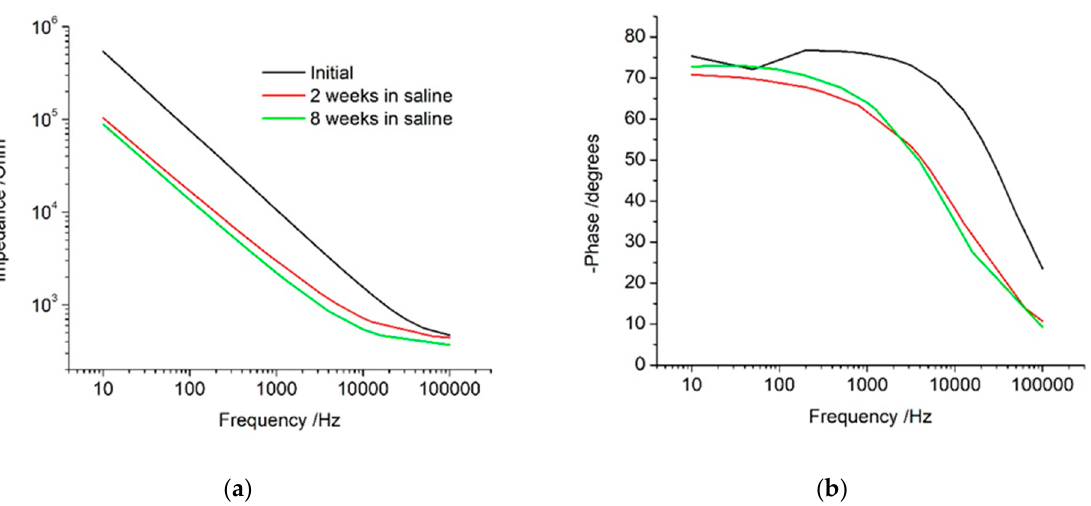
Figure 2. ( a ) Impedance; ( b ) Phase Angle. Electrochemical impedance spectroscopy of a platinum cochlear implant electrode at 0 V with an AC amplitude of 10 mV before cyclic voltammetry. Electrode tested and stored in saline over 8